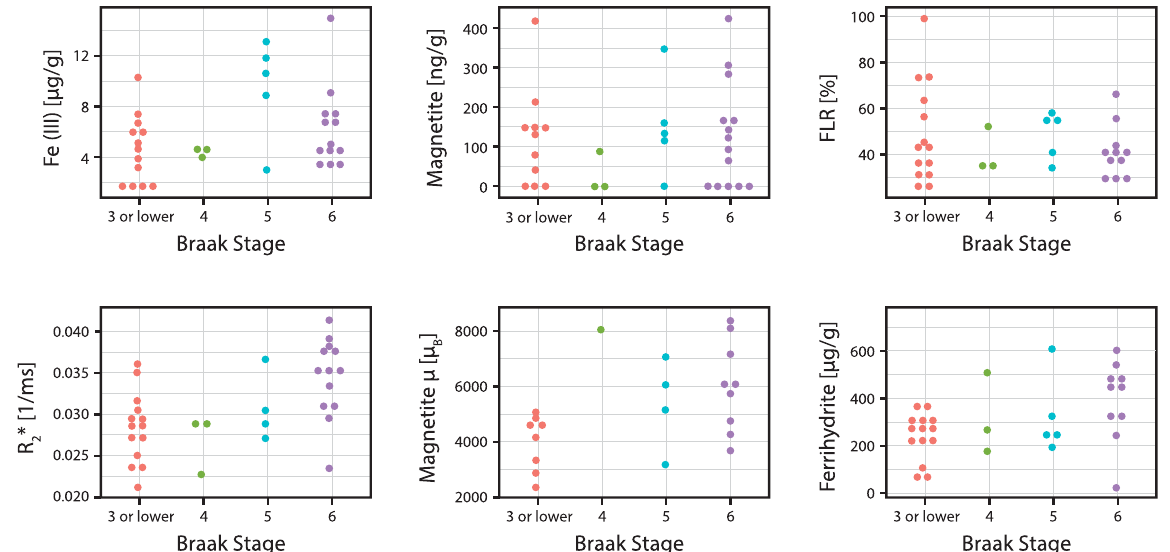
Figure 2. Visual representation of the iron forms grouped by Braak Stage. Each plot represents the concentration/magnetic property of the different iron forms grouped by the Braak Stage-number (outliers have been removed). All controls with Braak Stage equal to 3 or lower have been grouped in the variable “Braak Stage 3”. The AD patients have Braak Stage varying from 4 to 6. The μ symbol refers to the magnetic moment of the magnetite particle. For missing data in the ‘Magnetite μ ′ variable, please see Materials and Methods.